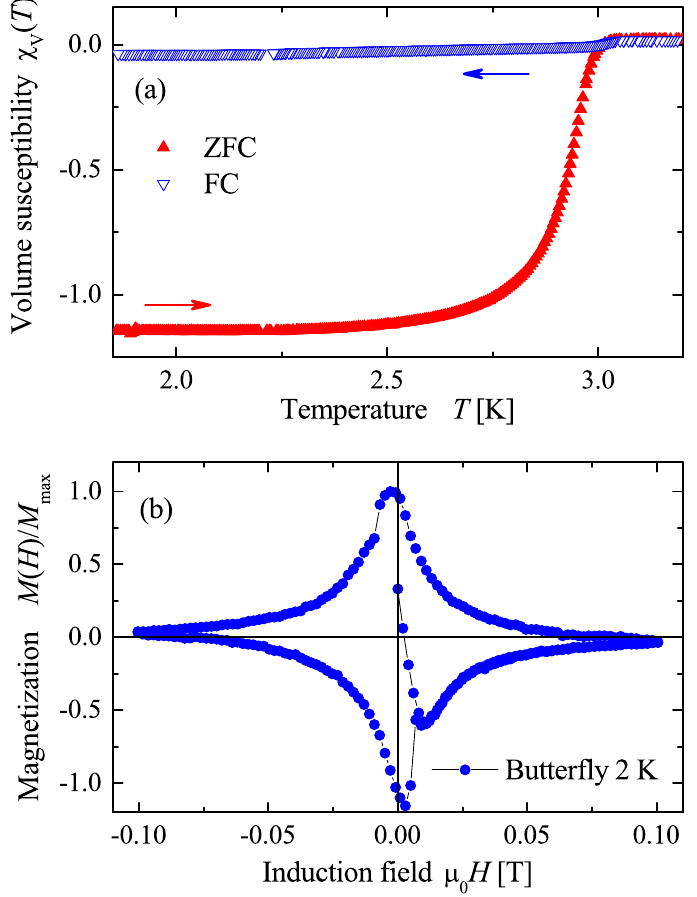
Figure 5. Diamagnetic shielding and Meissner effect for AuPdScAl. Panel ( a ) shows the temperature dependence of the susceptibility in a magnetic induction field of 2.5 mT under zero field cooled (ZFC) and field cooled (FC) conditions. Panel ( b ) shows the butterfly loop for AuPdScAl at 2